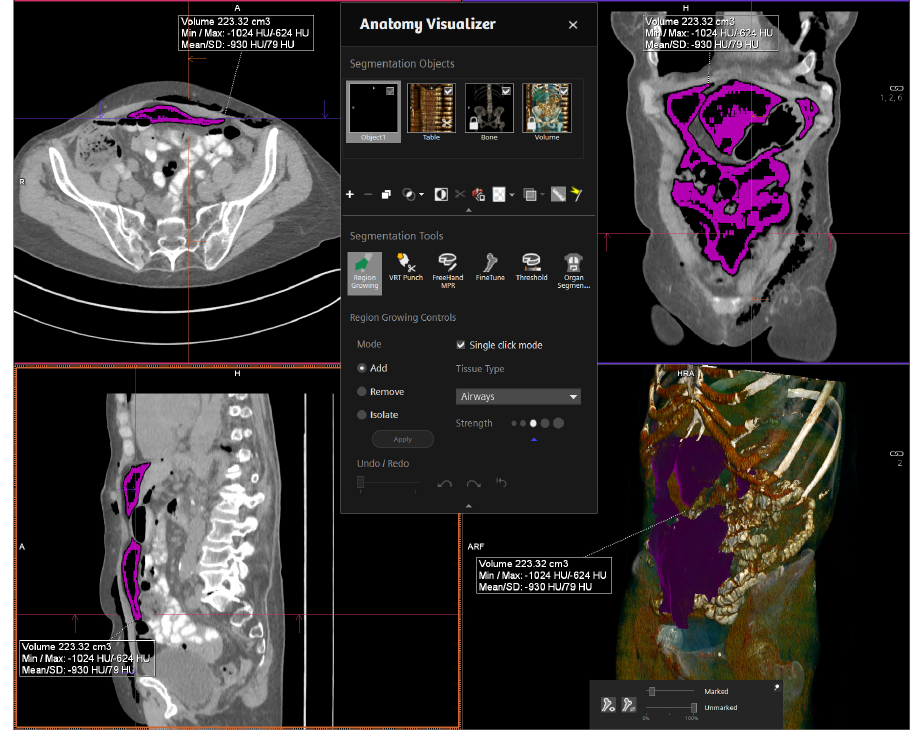
Figure 1. Volume measurement software interface.